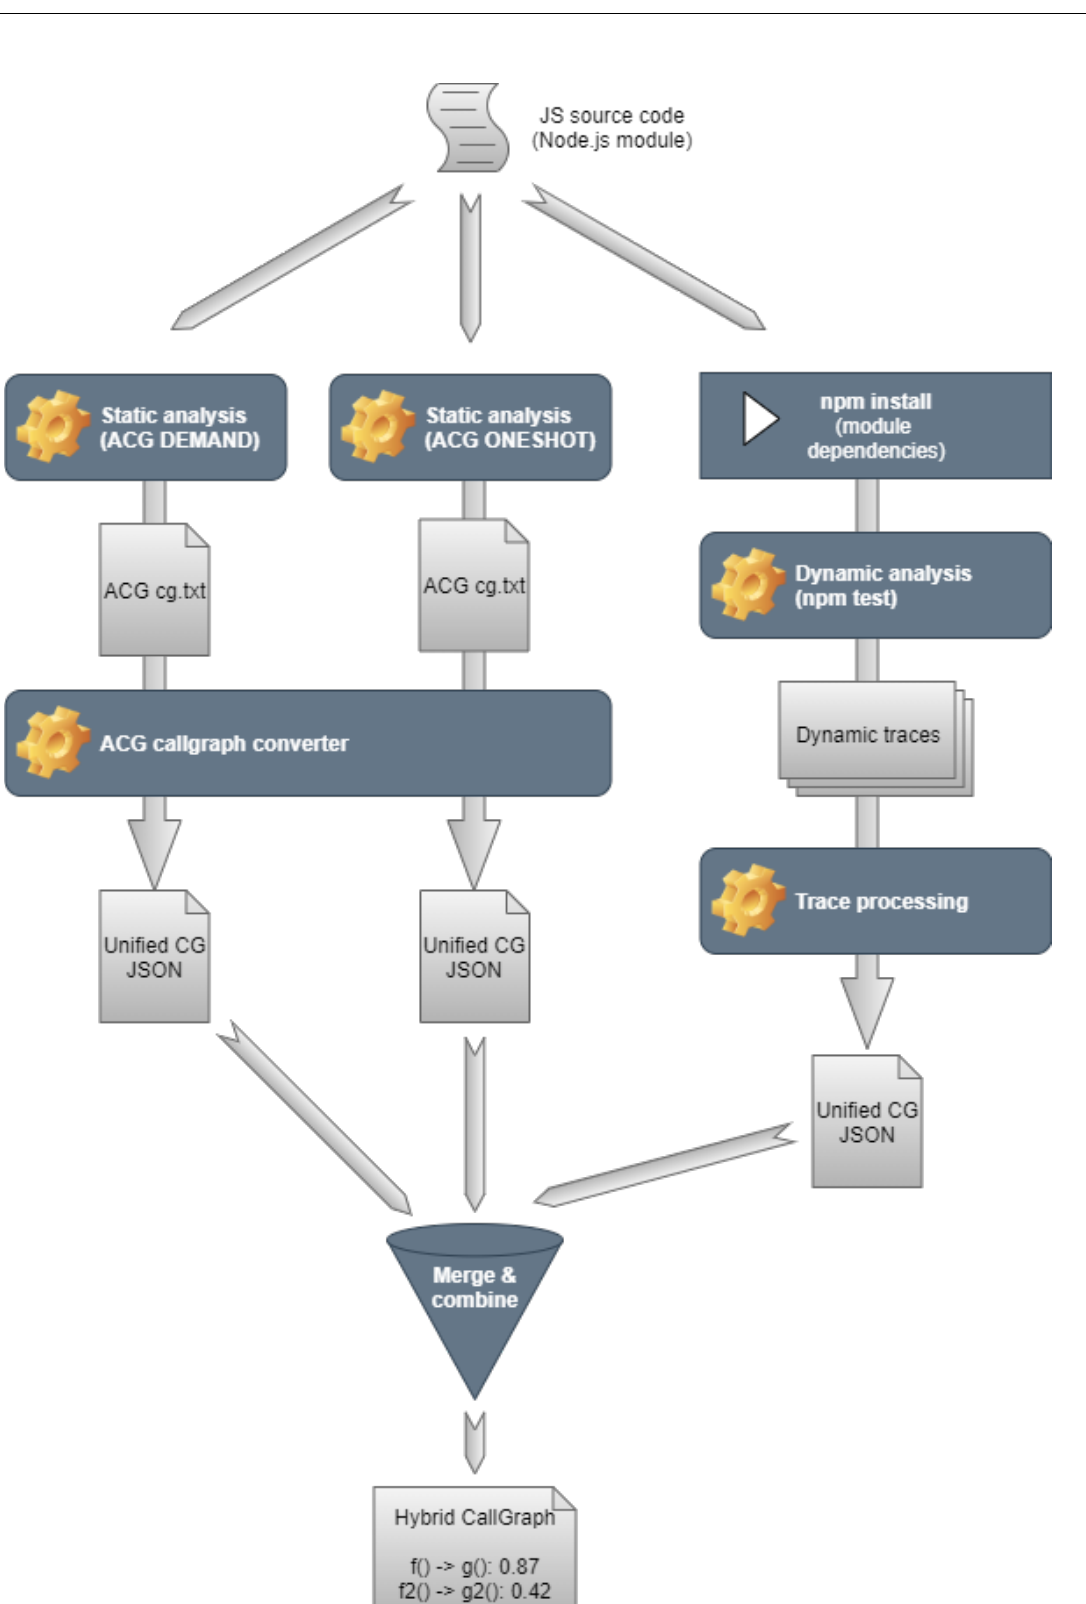
Figure 2. Hybrid call-graph framework